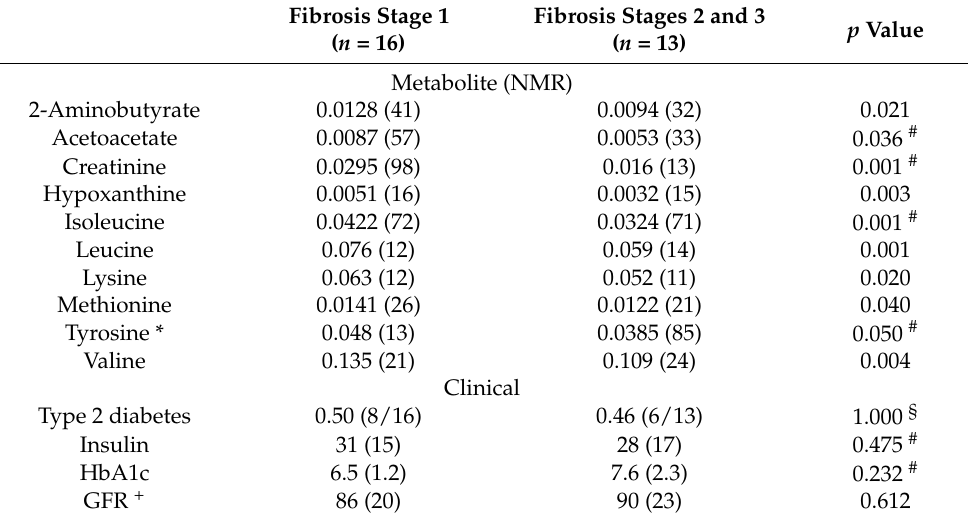
Table 4. Comparison of metabolite means as a function of fibrosis staging, with selected clinical variables. p values obtained from independent-samples t -test. Multiply concentrations by 2 for the original serum